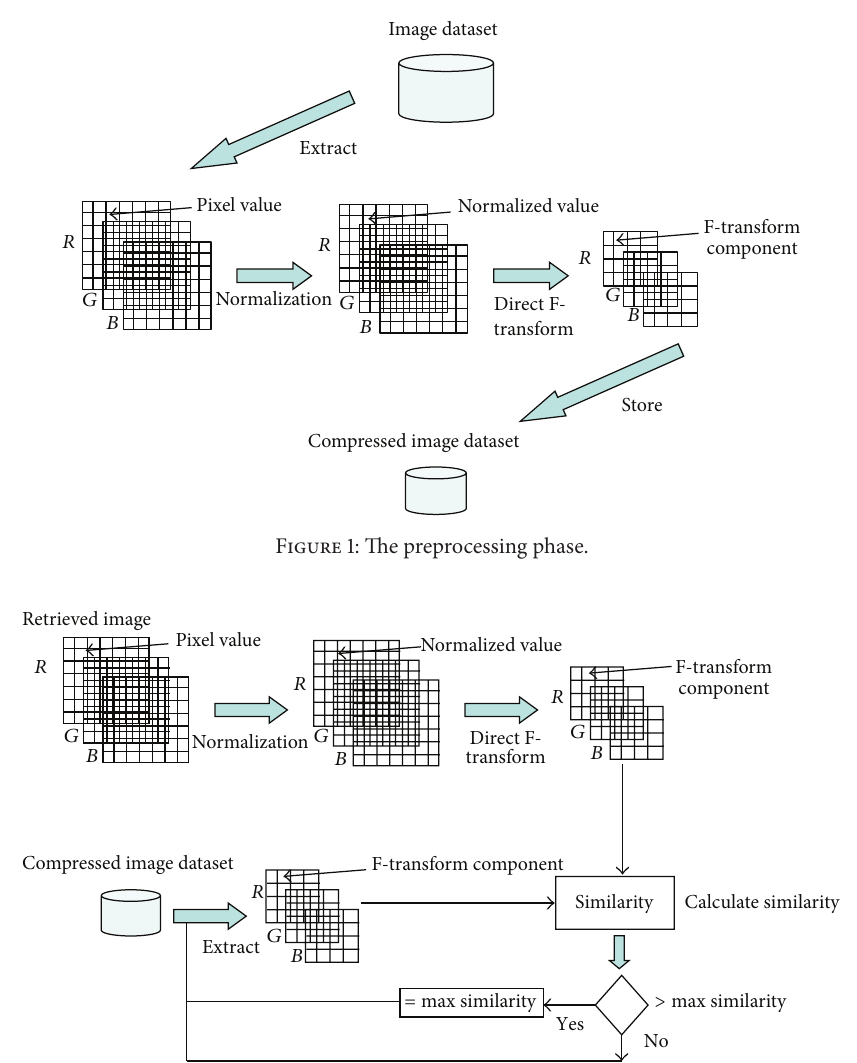
Figure 2: F-transform image matching